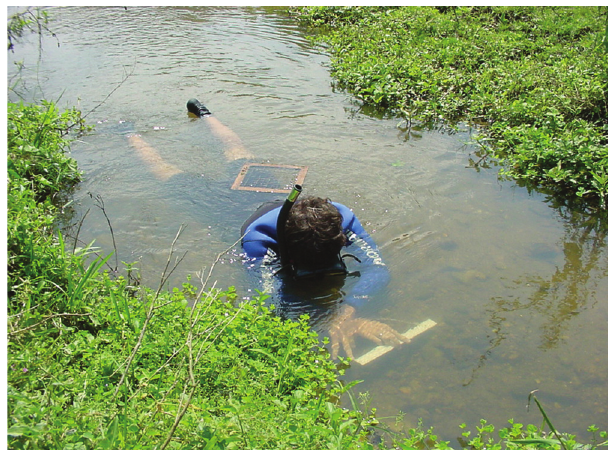
Fig. 2. Microhabitat underwater observation. In detail substratum measurements (Photo: Rosana Mazzoni).